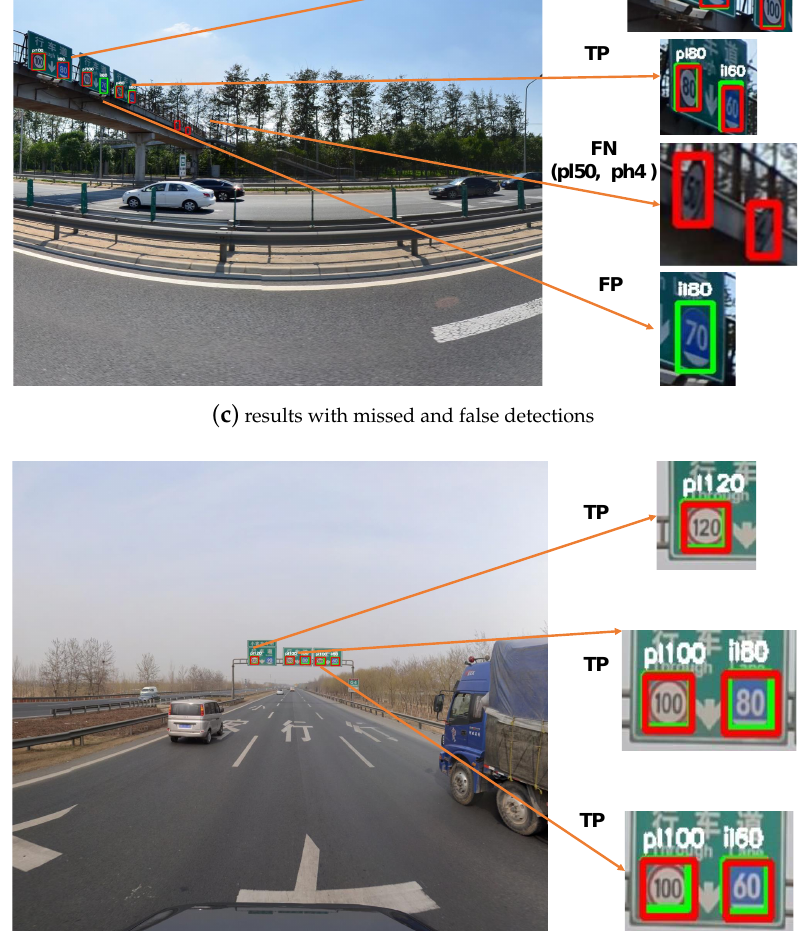
Figure 4. Detection results of images from the Tsinghua-Tencent 100K test set. True positive (TP), false positive (FP), false negative (FN). The red boxes are ground-truth bounding boxes, the green boxes are detection results. ( a ) Results with missed detections, ( b ) results with missed detections, ( c ) results with missed and false detections, ( d ) results with all correct